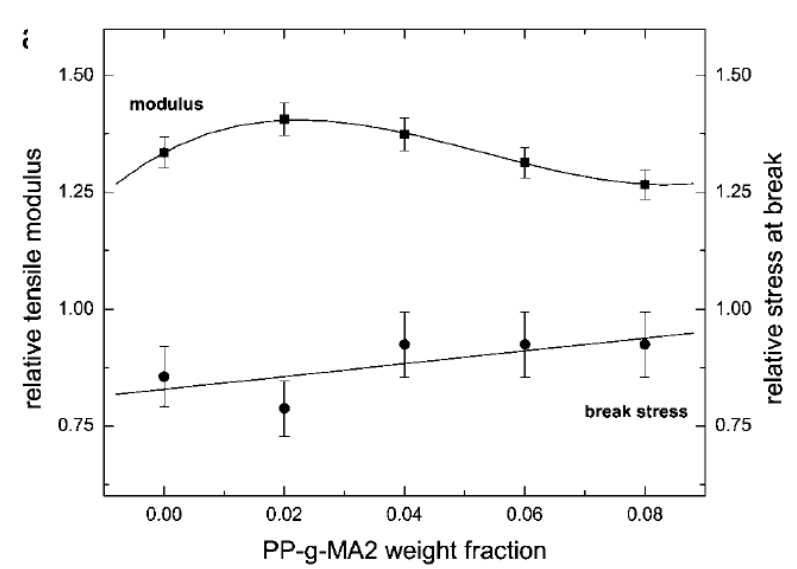
Figure 32. Tensile modulus and stress at break as a function of the amount of compatibilizer for the synthesis of polypropylene nanocomposites. Reproduced from reference